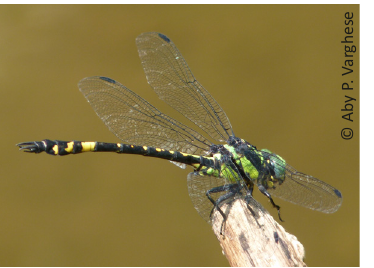
Image 1. Macromedia donaldi